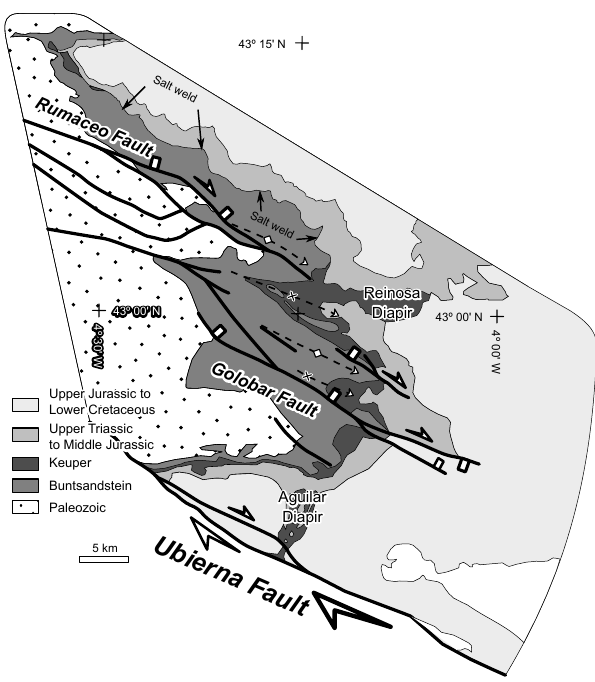
Fig. 16. Geological map of the Golobar and Rumaceo faults area.